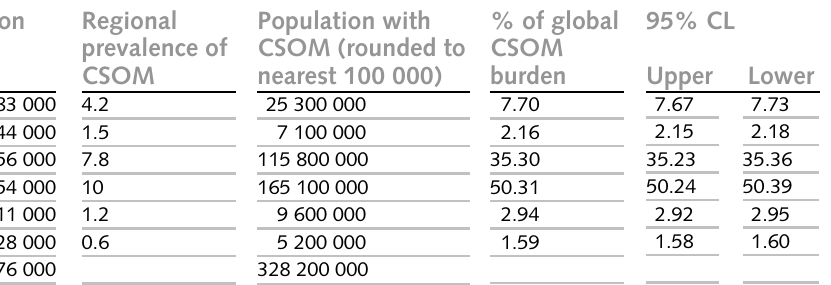
Table 4. Global distribution of CSOM, by region (using high prevalence